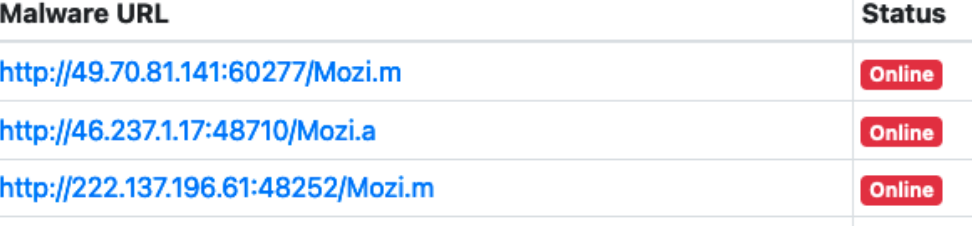
Figure 2. URLhaus malware tracking